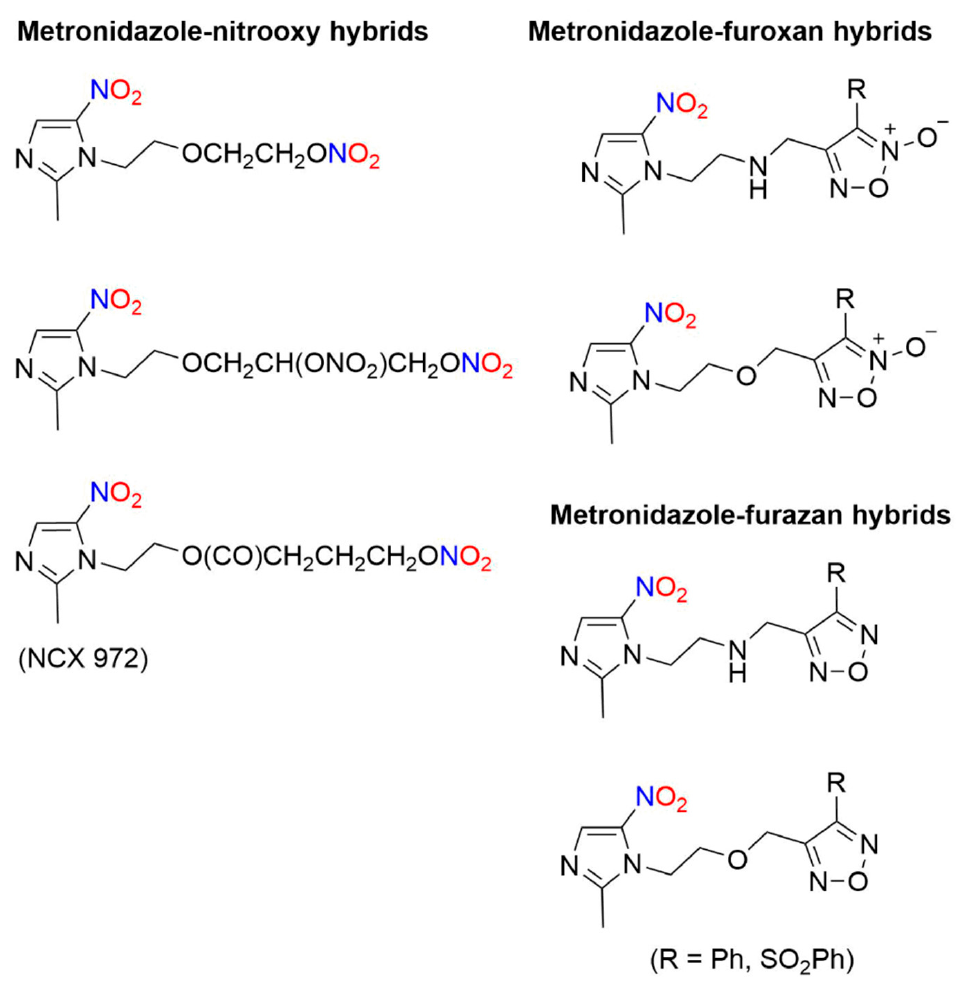
Figure 3. Structures of various metronidazole–NO donor hybrids [47,48]. NCX 972 ([4-(nitrooxy)butanoic acid 2-methyl-5-nitroimidazole-1-ethyl ester) combines the basic metronidazole structure with a nitrate ester, another known NO donor moiety (Figure 3) [48]. The in vitro effects of metronidazole were compared to NCX 972 in trophozoite cells for the treatment of amoebiasis against Entamoeba histolytica , a protozoan parasite [48]. NCX 972 releases NO into amoebic trophozoites as measured by the diaminofluorescein-2 diacetate (DAF-2DA) dye detection system that reacts with an oxidized NO species to generate irreversible DAF fluorescence [48]. In comparison, NCX 972 displays both higher and faster cell killing activity than metronidazole in E. histolytica , which correlates with NO release into the cells [48]. These data could portend new avenues for drug derivatization with NO-releasing moieties to already established drugs. Similarly, the mechanism of action of quinoline–metronidazole hybrids was recently investigated against visceral leishmaniasis (VL) [49]. The rationale for merging the two compounds stems from the use of metronidazole to combat experimental VL, especially in combination with other drugs [50–53], along with the activity of quinolines and their derivatives against in vitro and in vivo forms of experimental and cutaneous VL [54,55]. To determine the anti-leishmanial potency of quinoline − metronidazole derivatives, inhibition of promastigotes and intracellular amastigotes of Leishmania donovani was tested at various concentrations with various regioisomeric compounds [49]. Compounds 4-methyl-2-(3-(2-(2-methyl-5-nitro-1H-imidazol-1-yl)ethoxy)phenyl)quinolone (1) and 4- methyl-2-(4-(2-(2-methyl-5-nitro-1H-imidazol-1-yl)ethoxy)phenyl)quinolone (2) (Figure 4) were found to be the most active as determined by a luciferase and 3-(4,5- dimethylthiazol-2-yl)-2,5-diphenyltetrazolium bromide (MTT) assay, while 2 most effectively inhibited parasites in the liver and spleen of infected mice [49]. To examine NO release in relation to leishmanicidal action, the DAF-2DA dye assay was utilized, which implies local NO formation in living cells at the intracellular level, and revealed 2 leads to